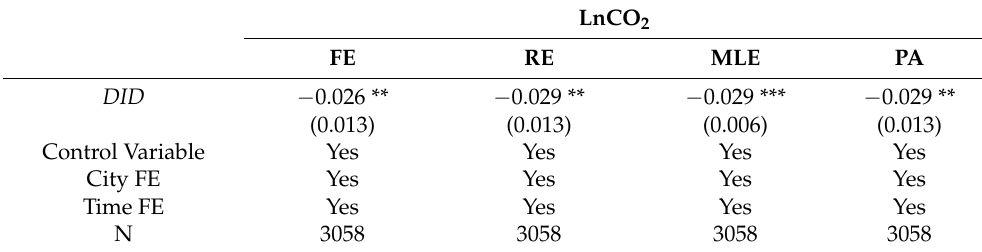
Table 9. Different estimation